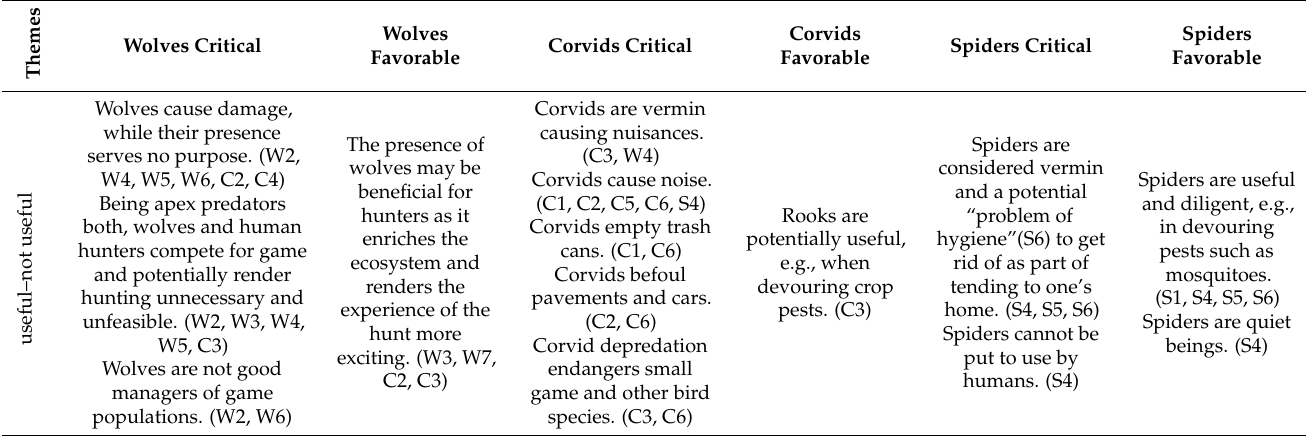
Table 2. The elements constituting participants’ mental images of wolves, corvids, and